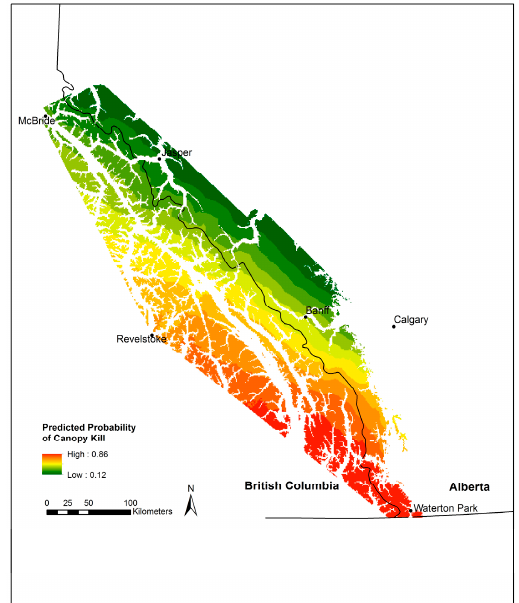
Figure 7. Predicted probability of canopy kill. This map was based on predictions for 2014 using quantile classification with 10 bins of predictions for trees nested in plots. Areas below 1579 m were clipped from the map consistent with our lowest elevation study